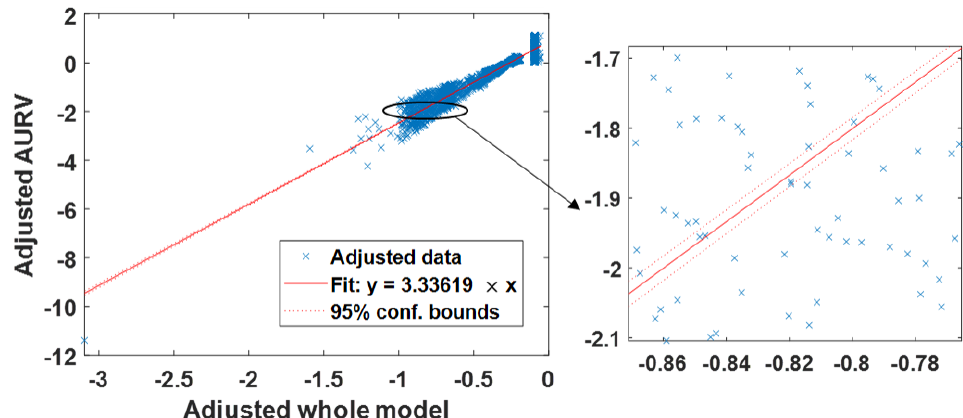
Figure 9. Added-variable plot for the linear regression